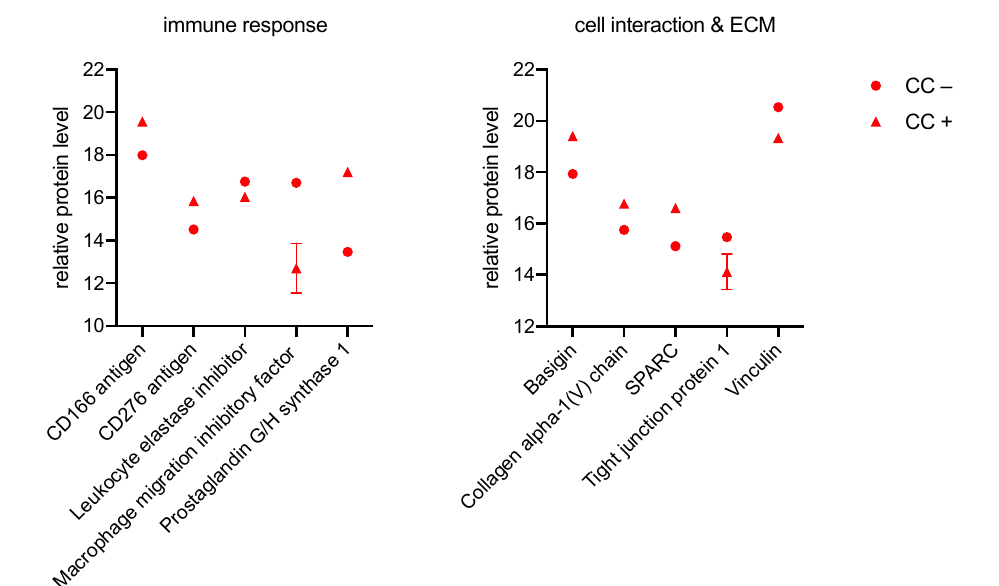
Figure 6. Significant proteins of the immune system ( left ), cell interaction, and ECM ( right ) measured in CC. Protein peak areas were transformed with a log2 scale, and bacterial conditions were compared pairwise with standard conditions using a Student’s t -test ( p < 0.05) and Benjamini-Hochberg correction for multiple tests. “+” indicates culture with bacteria; “ − ” indicates culture without bacteria.